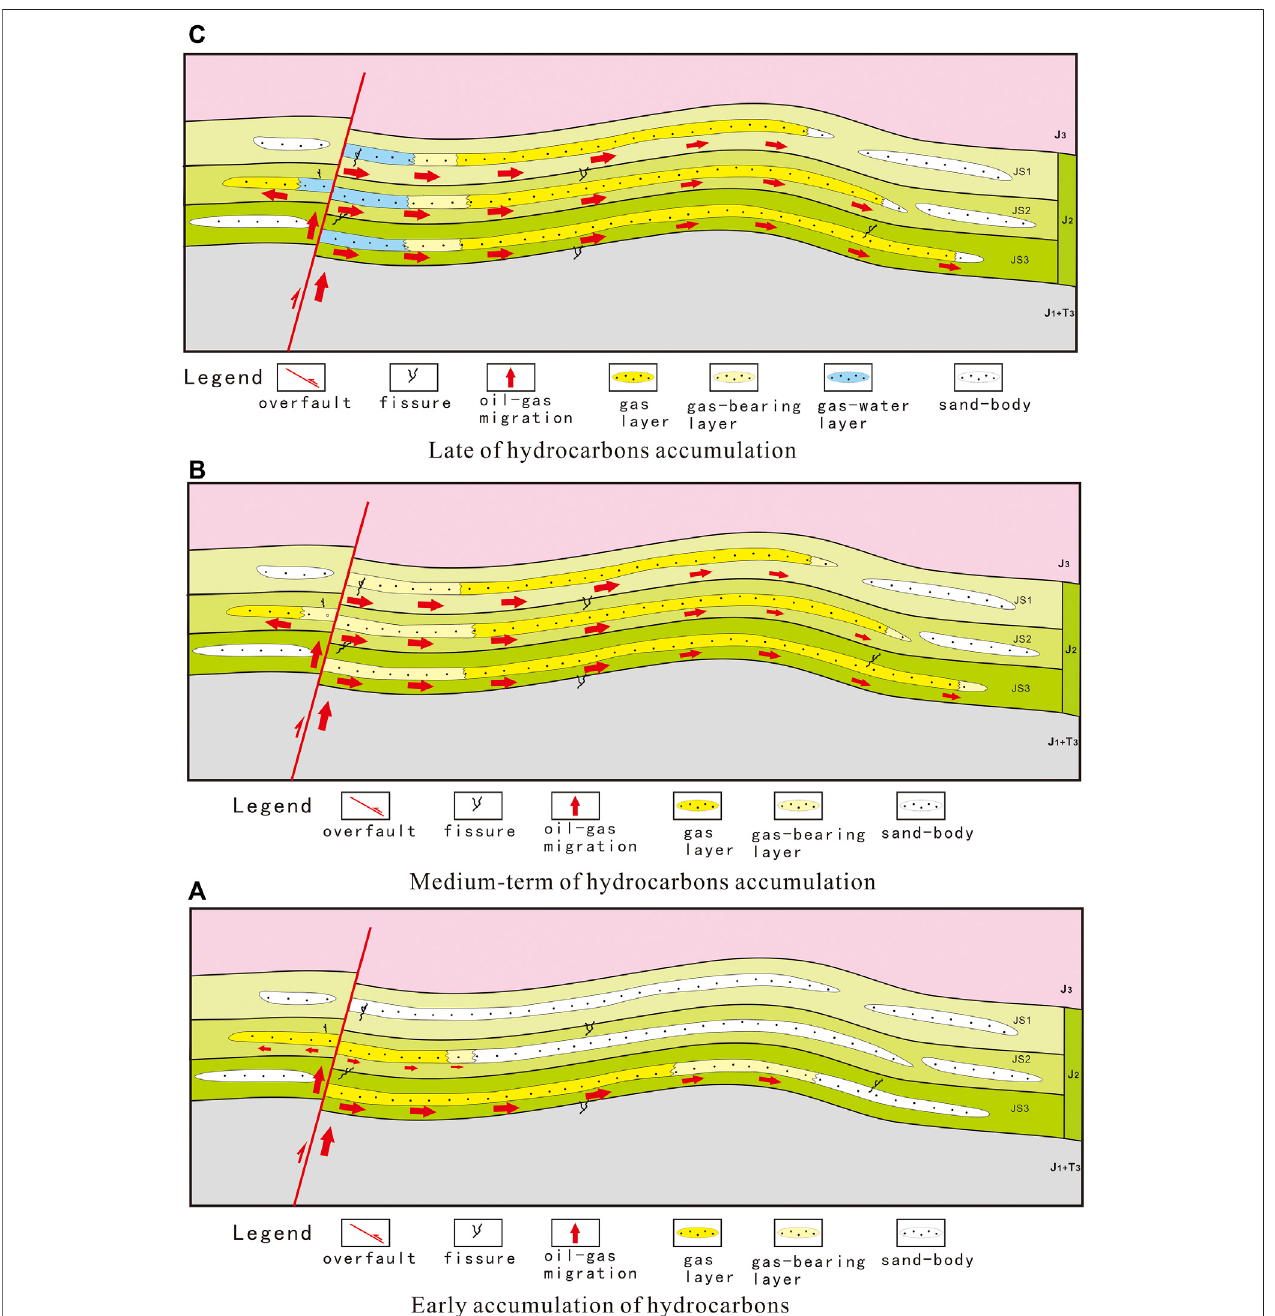
FIGURE 7 | Dynamic model evolution of the Middle Jurassic Shaximiao Formation in the Zhongjiang gas fi eld (A,B,C) .